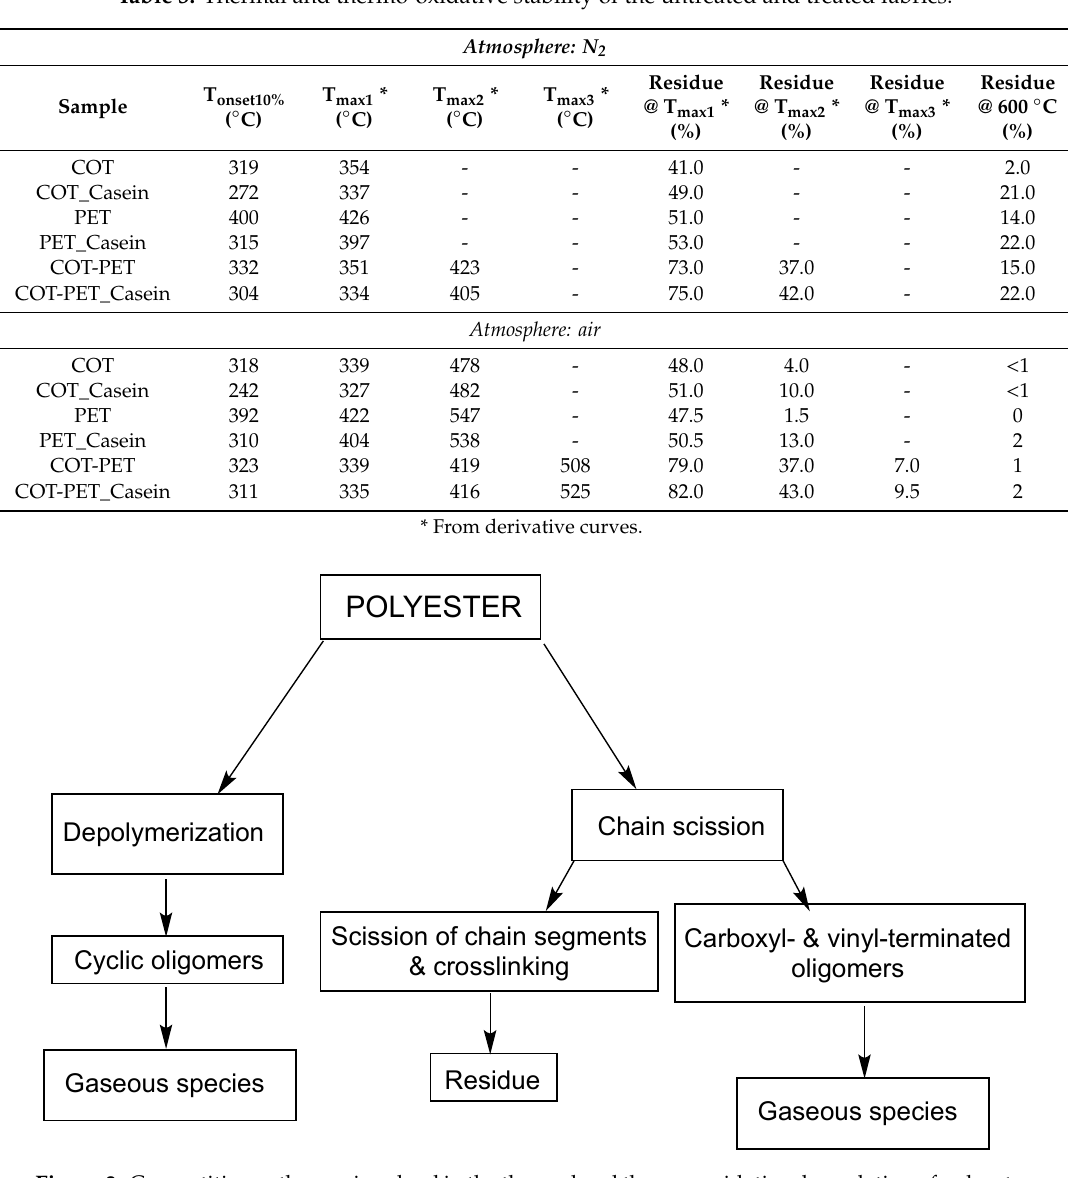
Figure 3. Competitive pathways involved in the thermal and thermo-oxidative degradation of polyester. Table 5. Cone calorimetry data for untreated and caseins-treated fabrics.